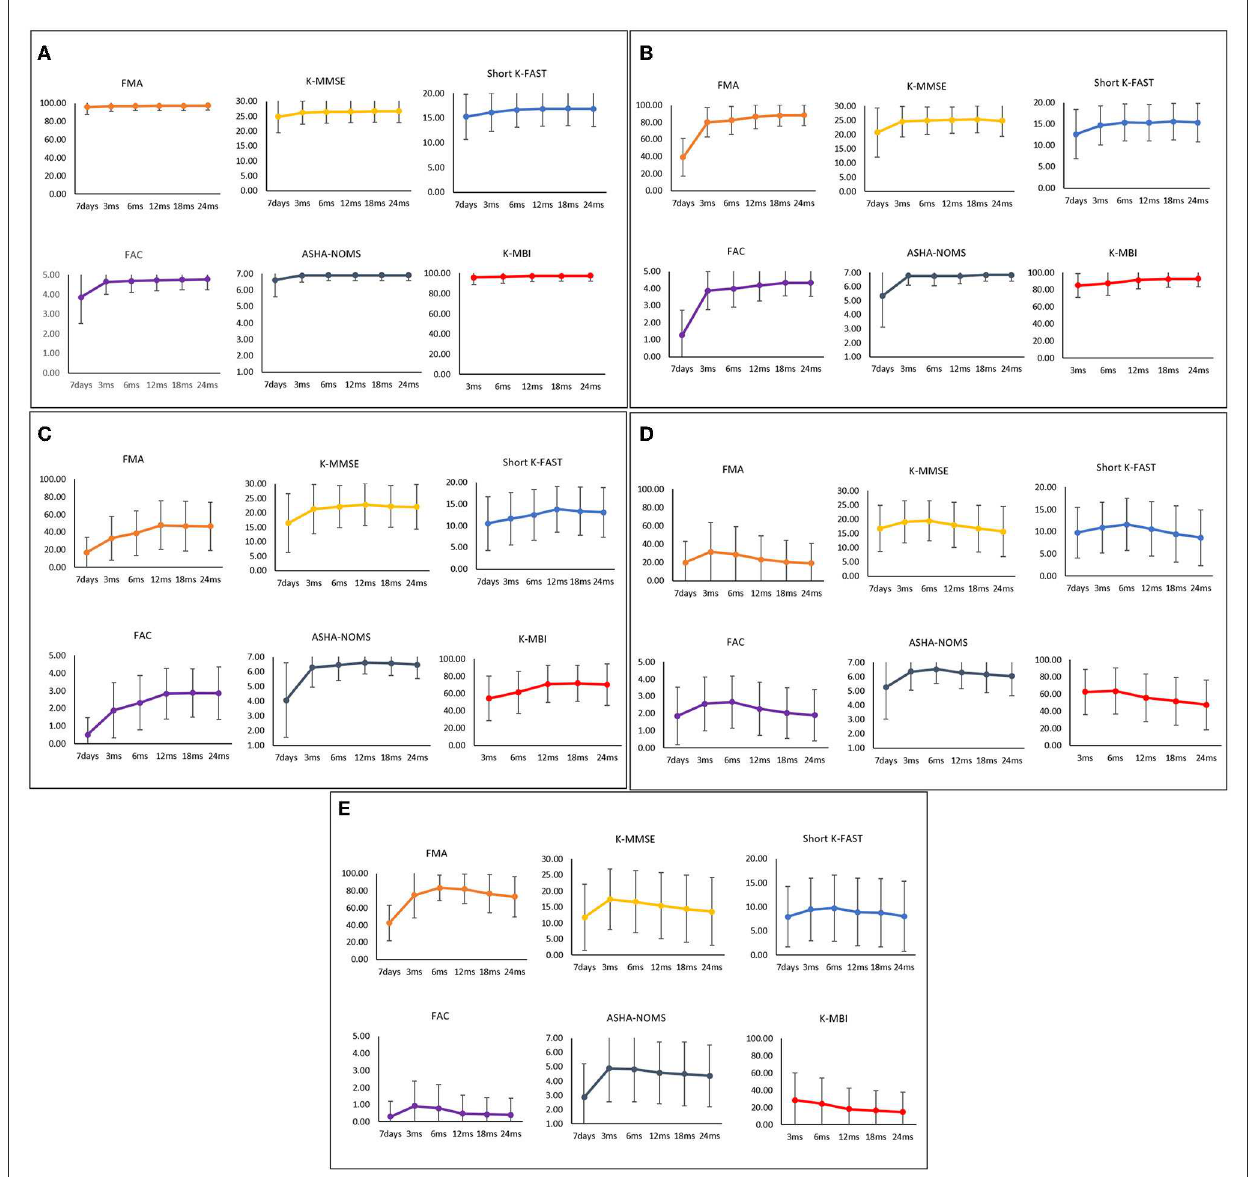
FIGURE3 Functional recovery patterns of clusters of ischemic stroke patients until 24 months after onset. (A) Cluster 1 ( n = 3,346); minimal functional deficit in all domains, (B) Cluster 2 ( n = 405); rapid improvement of motor and ambulatory functions during the subacute phase, (C) Cluster 3 ( n = 232); significant motor and ambulatory dysfunctions with continuous improvement, (D) Cluster 4 ( n = 204); moderate dysfunctions with late phase decrement, (E) Cluster 5 ( n = 201); severe dysfunctions in all domains. FMA, Fugl-Meyer Assessment; FAC, Functional Ambulatory Category; K-MMSE, Korean Mini-Mental State Examination; Short K-FAST, Short Korean version of the Frenchay Aphasia Screening Test; AHSA-NOMS, American Speech-Language-Hearing Association National Outcome Measurement System Swallowing Scale; K-MBI, Korean modified Barthel